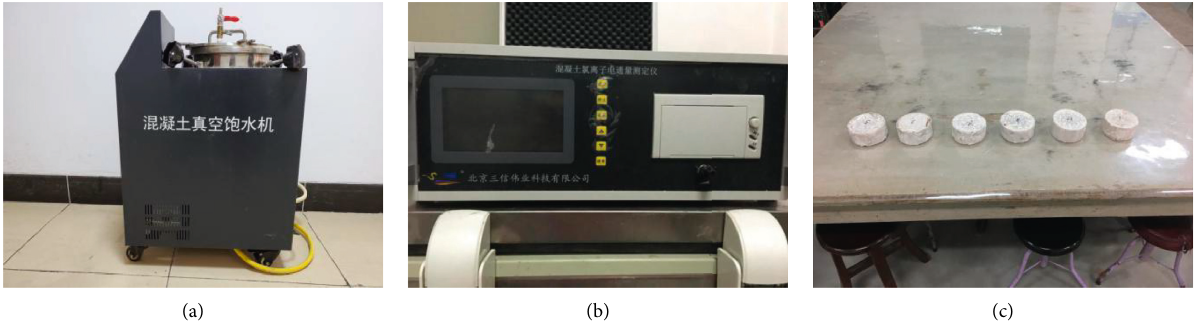
Figure 6: Chloride penetration measurement. (a) Concrete vacuum filling machine. (b) Concrete chloride-ion electric flux tester. (c) Specimens for electric flux test.